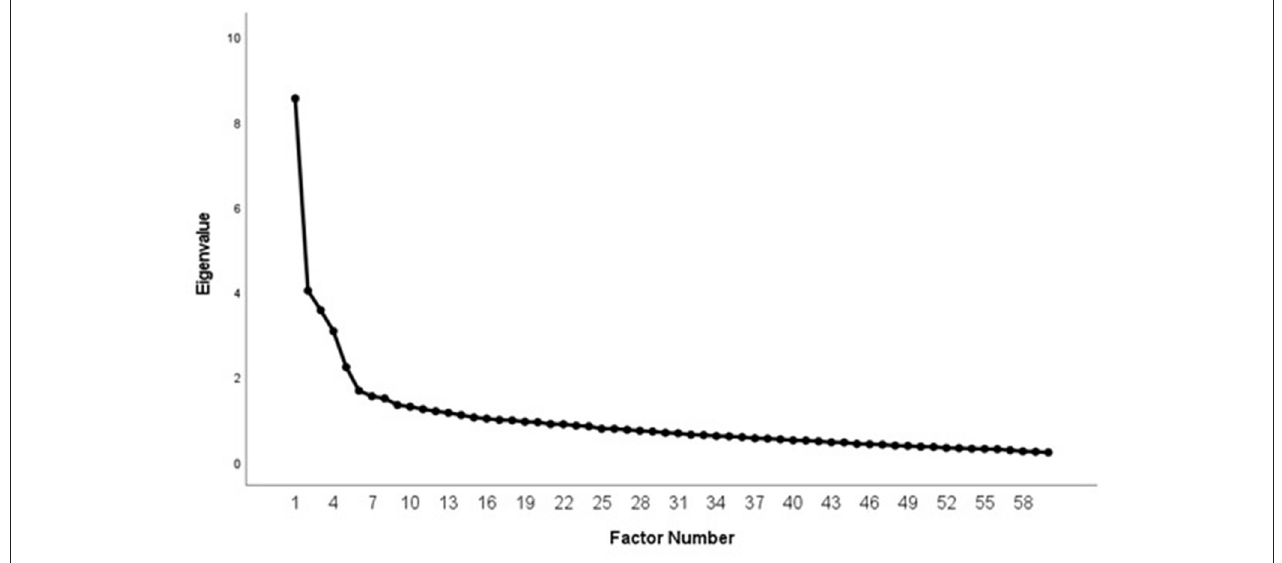
FIGURE 2 | NEO-FFI item-analysis. Component scree